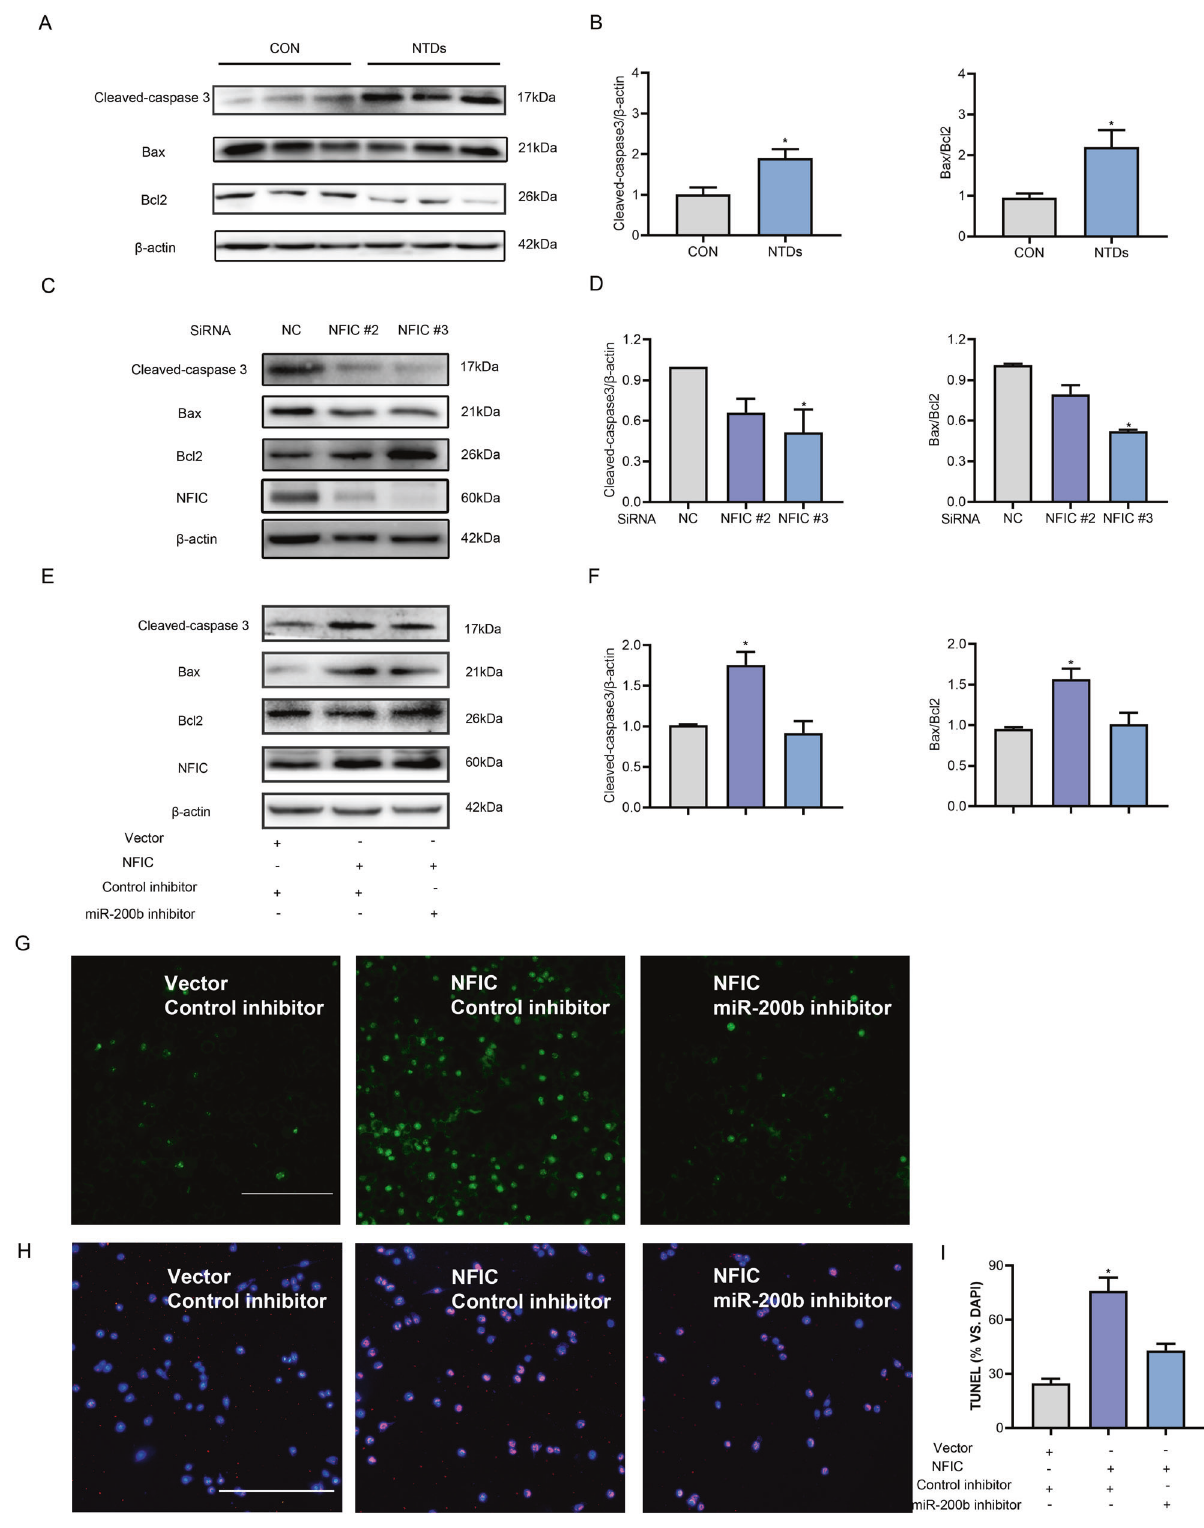
Fig. 5 NFIC-miR-200b circuit triggers apoptosis in C17.2 cells. A , B Protein levels of apoptosis markers (Cleaved-caspase 3, Bax, and Bcl-2) in E9.5 NTD mouse embryos compared with the control group ( n = 3). C , D Protein expression of Cleaved-caspase 3, Bax, Bcl-2, and NFIC estimated by western blot in cells transfected with the NFIC SiRNA or the control SiRNA. E , F Changes in Cleaved-caspase 3, Bax, Bcl-2, and NFIC proteins after transfection of the NFIC plasmid with or without the miR-200b inhibitor. Apoptotic cells are shown by representative confocal microscopic images of C17.2 cells cotransfected with the NFIC plasmid and the miR-200b inhibitor or control inhibitor, using the active caspase 3 assay, scale bar = 100 µm ( G ) and TUNEL assay ( H , I ), scale bar = 100 µm. Data from three replicate experiments are shown in the bar graphs. * P < 0.05 vs. control